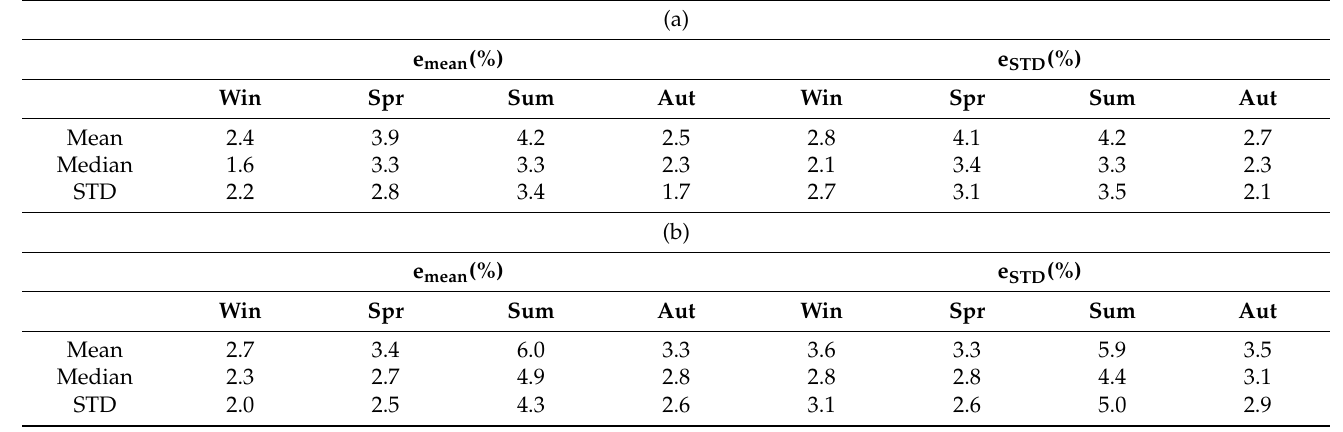
Table 3. (a) Mean, median, and standard deviation (STD) of the errors on the mean (e mean ) and standard deviation e STD ) evaluated in the case of synthetic hourly precipitation profiles, for the Patern ò case study. (b) Mean, median, and standard deviation (STD) of the errors on the mean (e mean ) and standard deviation (e STD ) evaluated in the case of synthetic hourly precipitation profiles, for the Busachi case